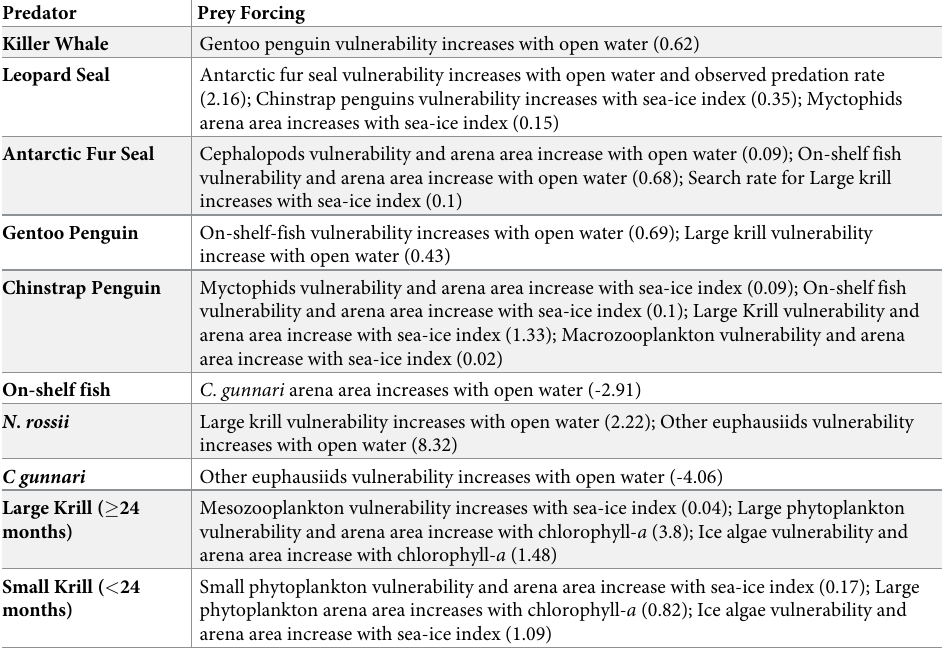
Table 3. Forcing function applications retained in the final model to influence predator-prey interactions.